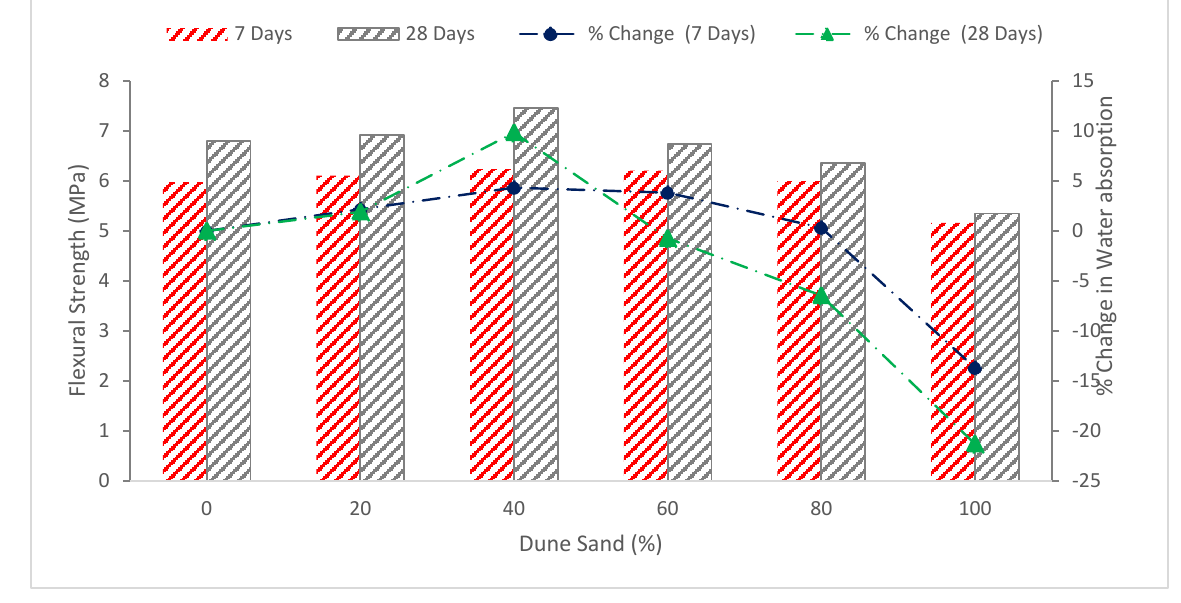
Figure 7. Flexural strength: data source [40].